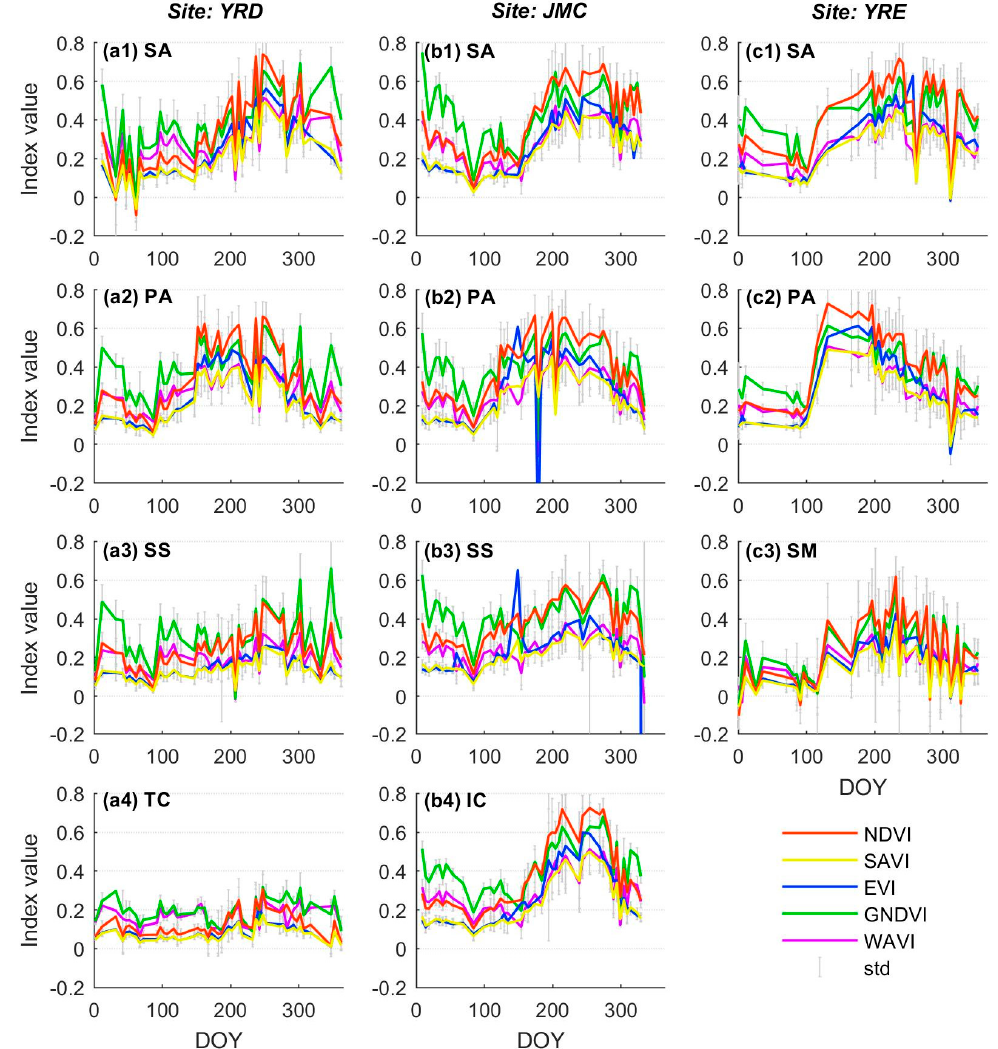
Figure 5. Trends and associated fluctuations for the different VI time series corresponding to different salt marsh vegetation types. Each sub-figure within the same column corresponds to different salt marsh vegetation types within the same site. Note: SA = S. alterniflora , PA = P. australis , SS = S. salsa , TC = T. chinensis , IC = I. cylindrica , and SM = S. mariqueter .